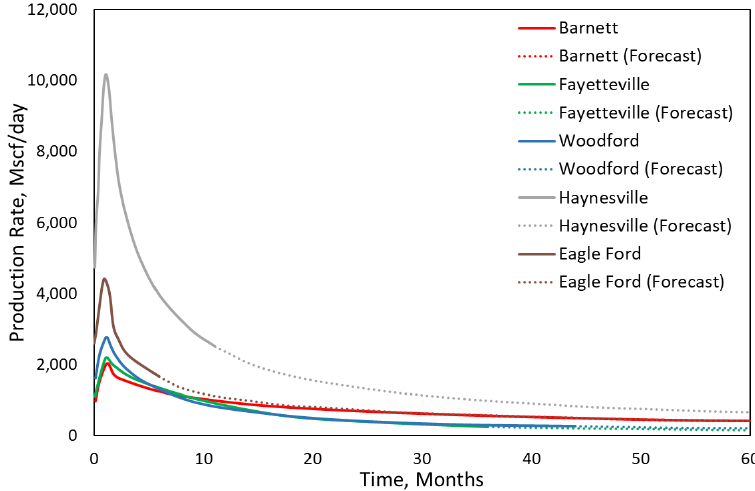
Figure 5. Absolute averaged daily gas production rate per well for different shale gas